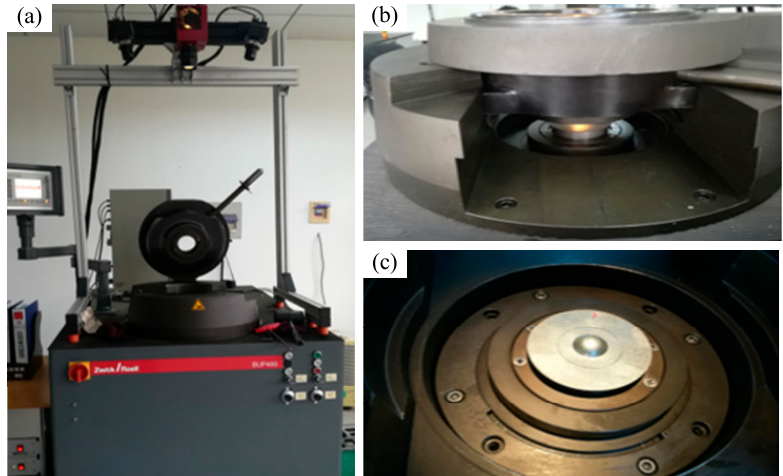
Figure 9. Hemispherical part drawing test device: ( a ) BUT400 drawing machine, ( b ) hemispherical part drawing die, ( c ) Lower die of hemispherical part drawing die.